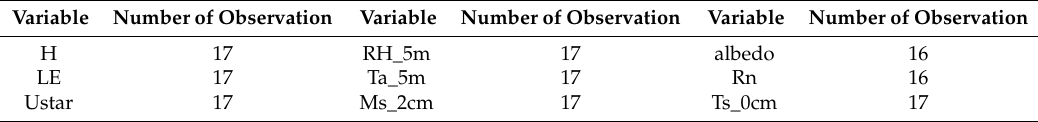
Table 5. The number of observations in the calculation of each